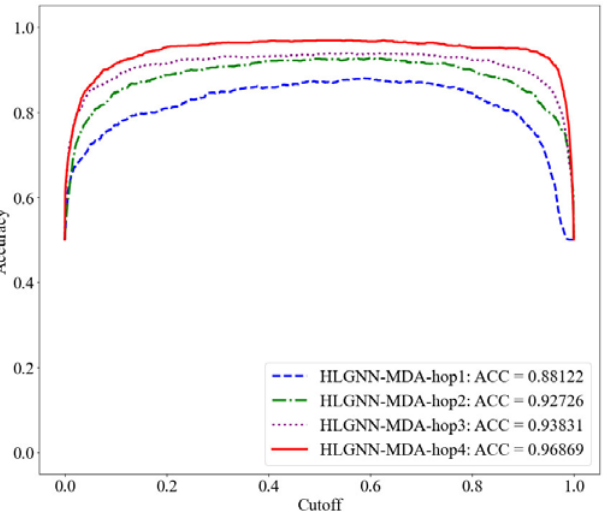
Figure 7. PR curve of HLGNN-MDA in different enclosing subgraphs.